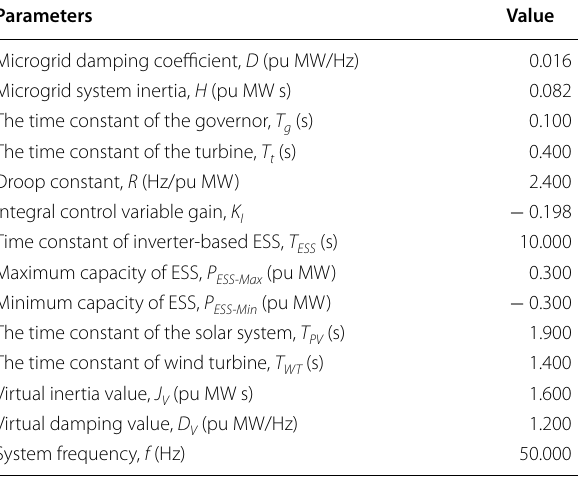
Table 1 Dynamic parameters of the studied islanded µG Parameters